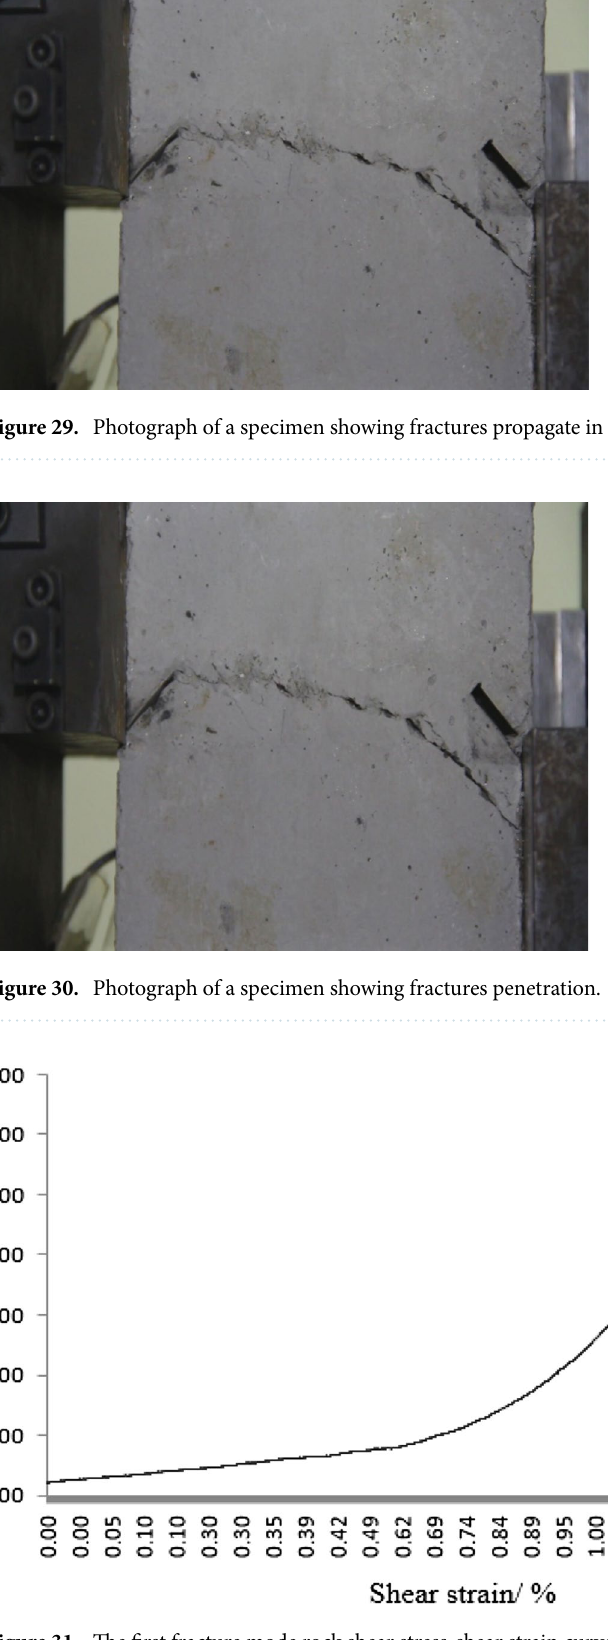
Figure 31. The first fracture mode rock shear stress-shear strain